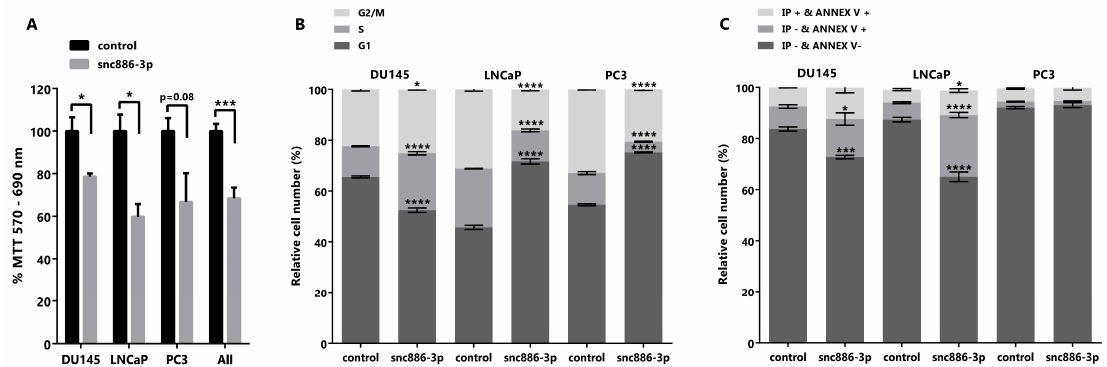
Figure 4. Cytotoxicity, cell cycle and early apoptosis assay in prostate tumor cell lines overexpressing snc886-3p. DU145, PC-3 and LNCaP cells transfected with 20 nM of mimic snc886-3p and negative